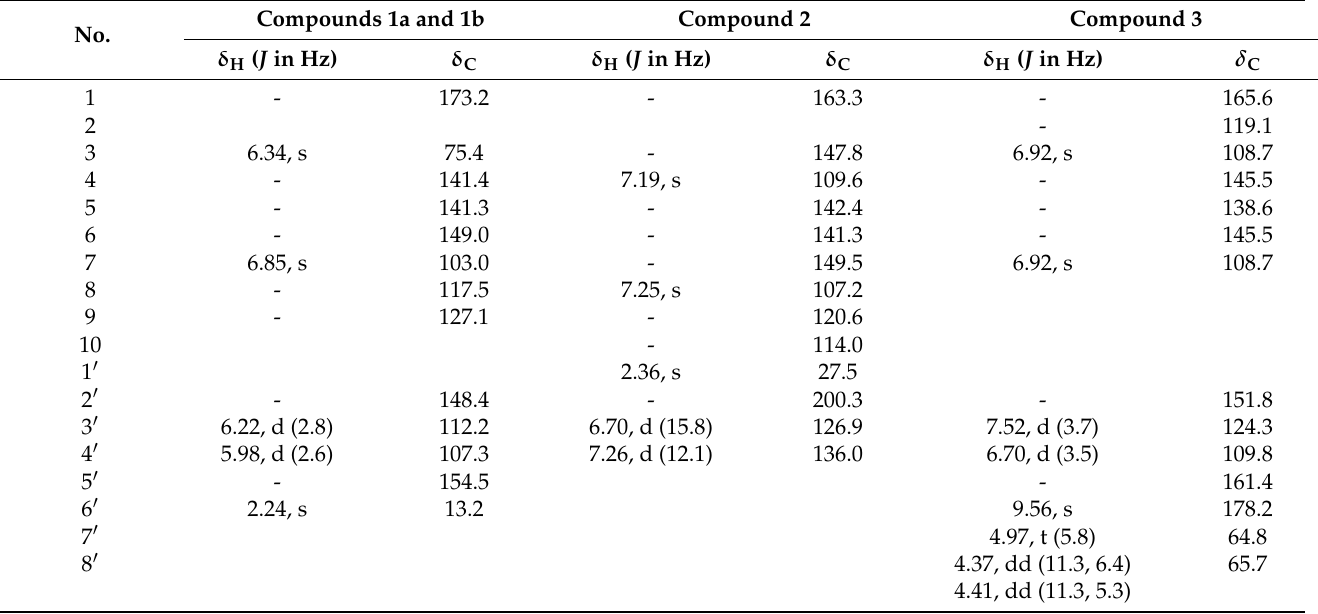
Table 1. 1 H-NMR and 13 C-NMR data of Compounds 1–3 a .